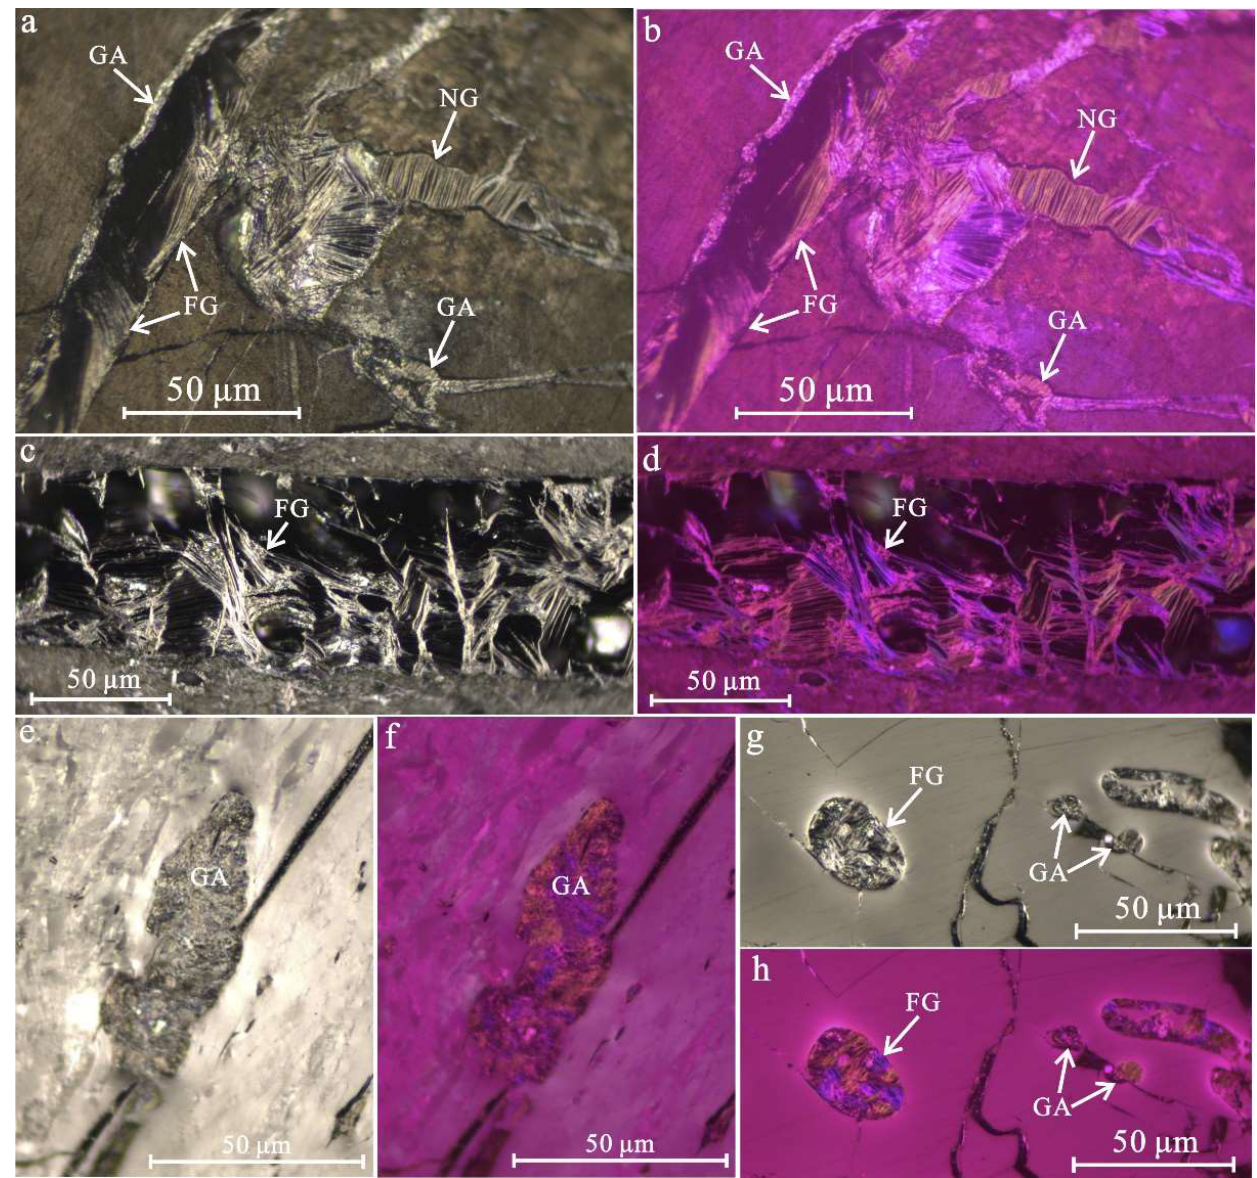
Figure 3. Morphology of graphite microcrystals in graphitized coal samples. ( a ) Flake-like graphite microcrystals (FG), needle-like graphite microcrystals (NG) and graphite microcrystal aggregates (GA) in sample PK, reflected single-polarized light; ( b ) the same field of view as a, polarized light and with a retarder plate of 1 λ ; ( c ) FG infilling the fracture in sample CO1, reflected single-polarized light; ( d ) the same field of view as ( c ) polarized light and with a retarder plate of 1 λ ; ( e ) GA infilling the cell, plane-polarized light in sample CO3; ( f ) the same field of view as ( e ), polarized light and with a retarder plate of 1 λ ; ( g ) FG and GA infilling the cell in sample QK, reflected single-polarized light; ( h ) the same field of view as ( g ) polarized light and with a retarder plate of 1 λ